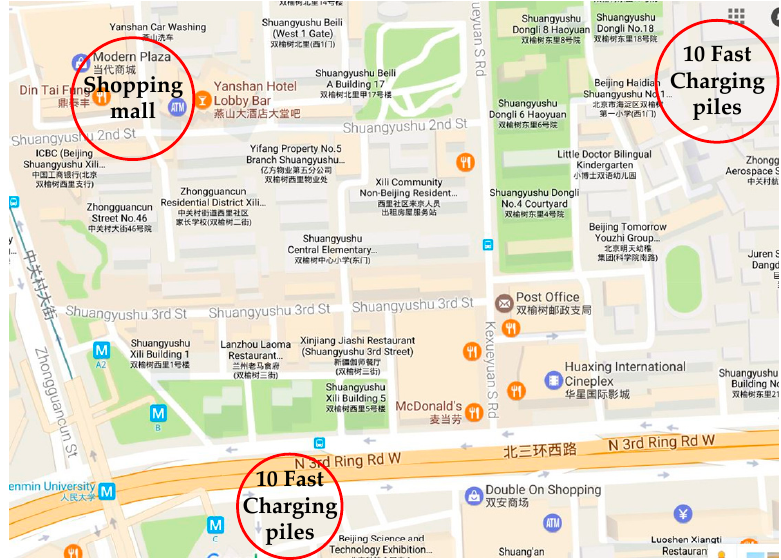
Figure 9. Geographical placement of the shopping mall and charging stations.